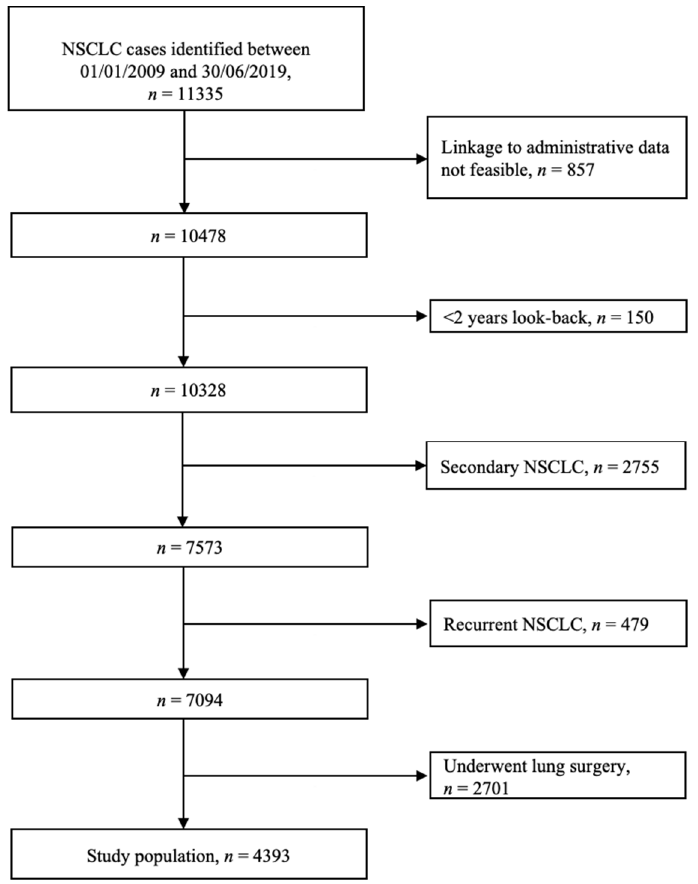
Figure 1. Flow chart of patient selection. Within the selected cohort, 2793 patients (63.6%) had a non-squamous, 1559 (35.5%) a squamous, and 41 (0.9%) unknown histology (Table 1). Table 1. Cohort characteristics by histology and sex.